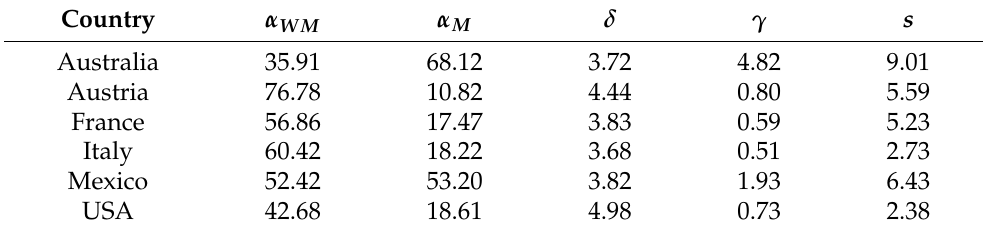
Figure 1. Value of ( a ) per capita capital and ( b ) per capita production in the SM model of integer order without migration for several countries. Table 1. Percentage average for several countries of: without migration ( α WM ), with Migration ( α M ), depreciation rate δ , Laboral Force Rate ( γ ) and Save Rate ( s